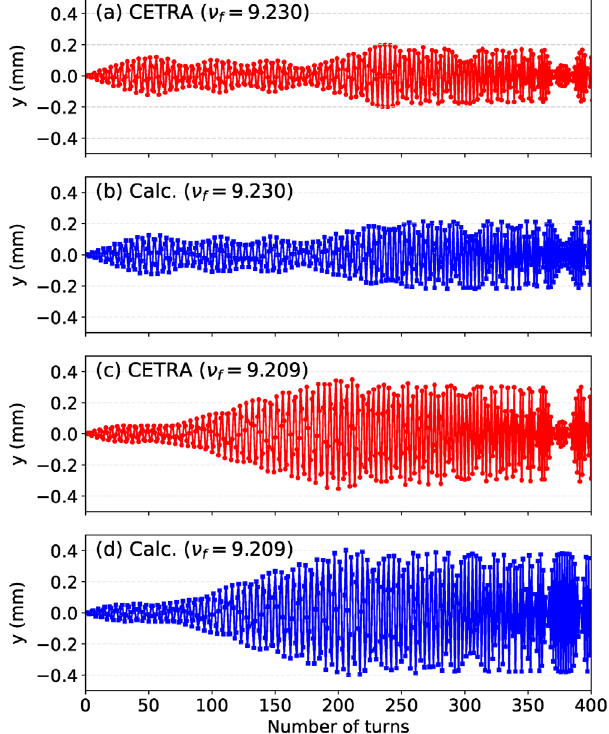
FIG. 2. Vertical betatron oscillation excited by the beam shaker at an observation point in the storage ring. (a) CETRA tracking and (b) model calculation with shaker ’ s tune (frequency) ν f ¼ 9 . 230 , and (c) CETRA tracking and (d) model calculation with ν f ¼ 9 . 209 . In both cases, the initial amplitude of betatron oscillation is set to zero and the magnitude of shaker ’ s kick is set to 2 μ